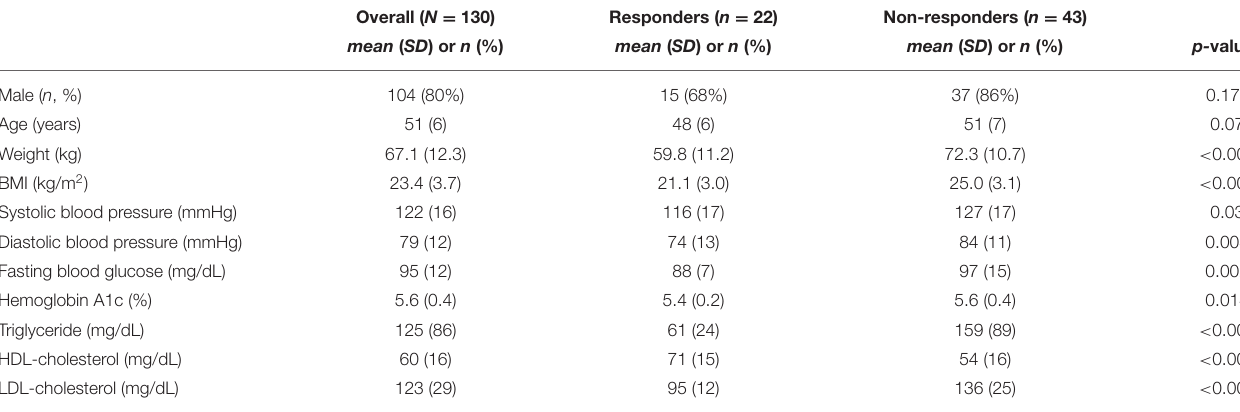
TABLE 1 | Characteristics of the study participants of each group.